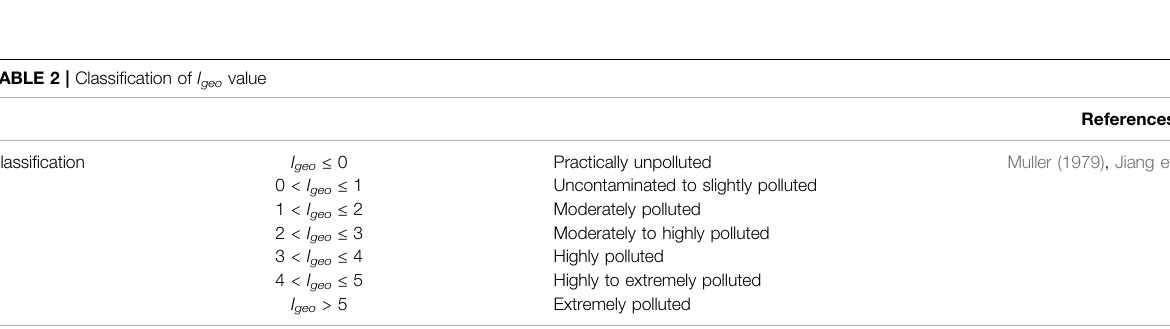
( “ Lumex ” , Russia). Chromatography was